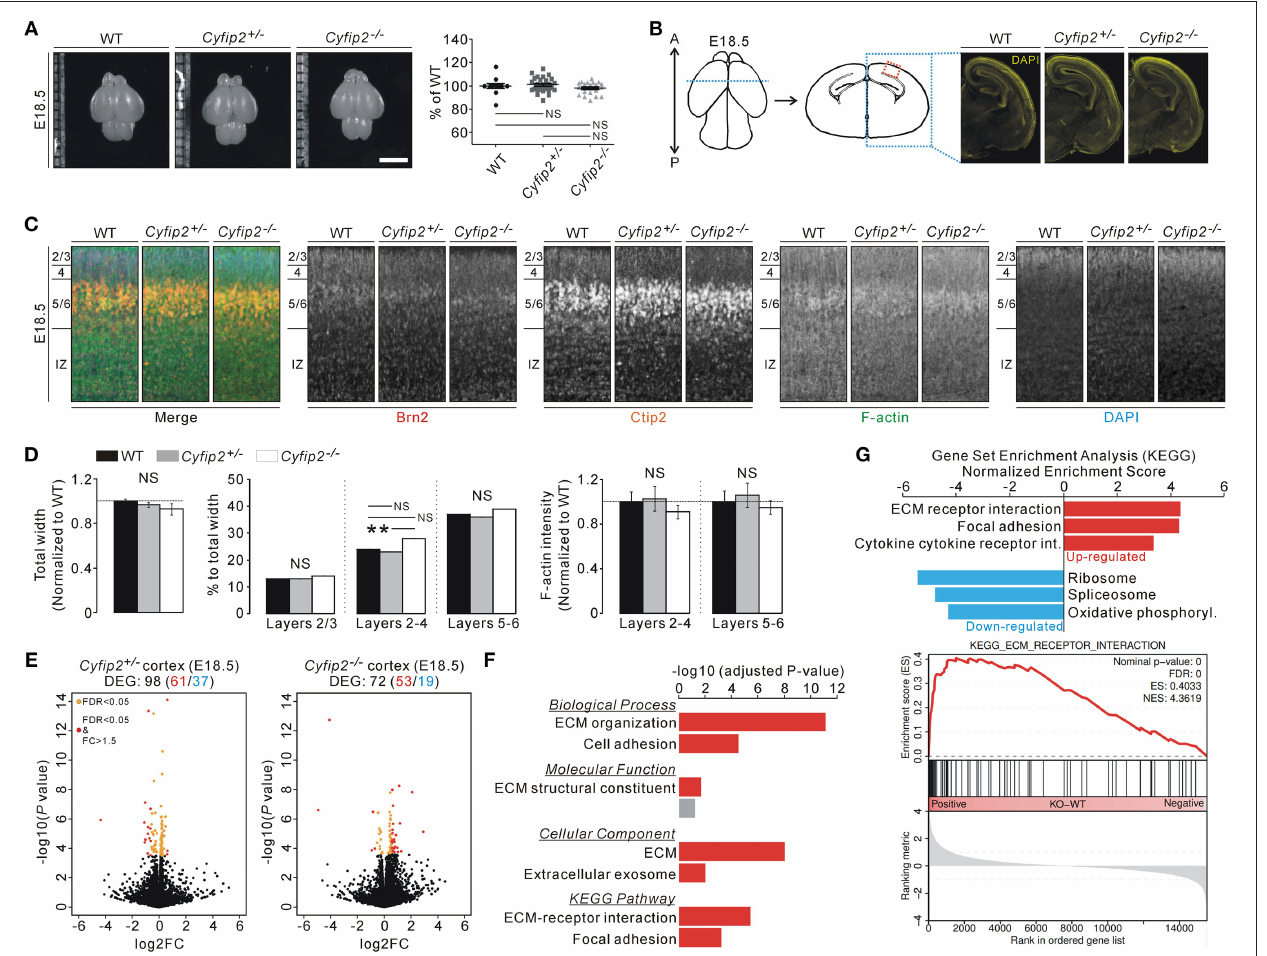
FIGURE 2 | Normal brain morphology, but cortical ECM-related gene expression changes of Cyfip2 − / − embryonic mice. ( A) Representative images and quantifications show normal brain size of E18.5 Cyfip2 − / − mice compared with WT and Cyfip2 + / − littermates ( n = 12, 31, 20 for WT, Cyfip2 + / − , and Cyfip2 − / − mice, respectively). NS, not significant. Scale bar, 3mm. (B) Schematic diagrams show the regions of interests (ROIs) for immunohistochemistry analysis (left panel). Representative images of DAPI staining show that overall brain morphologies are comparable among E18.5 WT, Cyfip2 + / − , and Cyfip2 − / − mice (right panel). A, anterior; P, posterior. (C) Representative images of Brn2, Ctip2, F-actin, and DAPI staining in E18.5 WT, Cyfip2 + / − , and Cyfip2 − / − cortex (the ROI is depicted in (B) , red box). IZ, intermediate zone. (D) Quantifications of the cortical cytoarchitecture in E18.5 WT, Cyfip2 + / − , and Cyfip2 − / − mice ( n = 12 sections from 6 WT, 14 sections from 7 Cyfip2 + / − , and 11 sections from 6 Cyfip2 − / − mice). (E) Volcano plots for the cortical RNA-seq analyses of Cyfip2 + / − (left panel) and Cyfip2 − / − (right panel) mice, respectively. DEGs, defined by FDR < 0.05, are shown as orange (FC = < 1.5) and red (FC > 1.5) circles. FC, fold change. (F) GO and KEGG pathway analyses of the DEGs of the Cyfip2 − / − embryonic cortex. (G) The bar graph shows normalized enrichment scores of GSEA on the KEGG gene sets for the cortical RNA-seq analysis of Cyfip2 − / − embryonic mice. The enrichment plot of cortical RNA-seq analysis of Cyfip2 − / − embryonic mice on the “ECM receptor interaction” gene set (lower